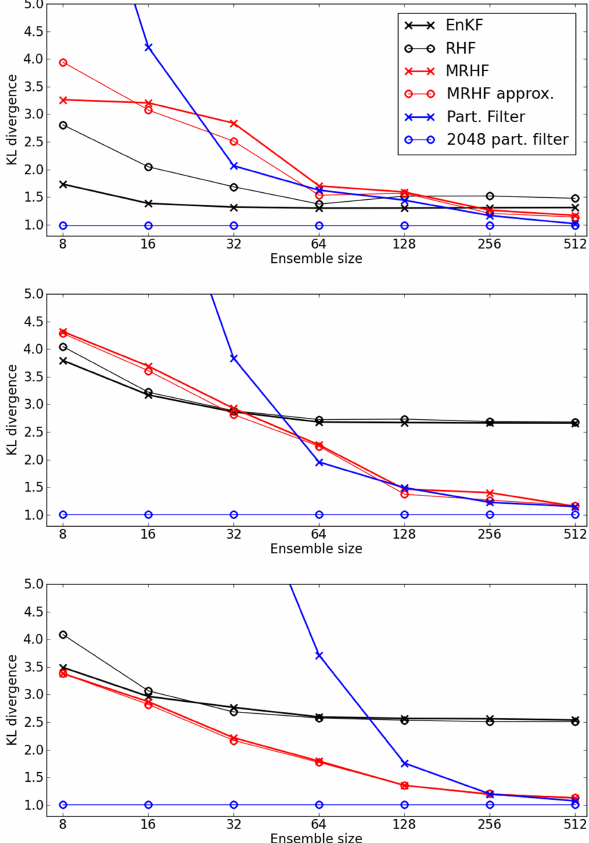
Figure 9. Same as Fig. 8 but for the mean Kullback–Leibler di- vergence on the X variable (results are similar on the Y and Z